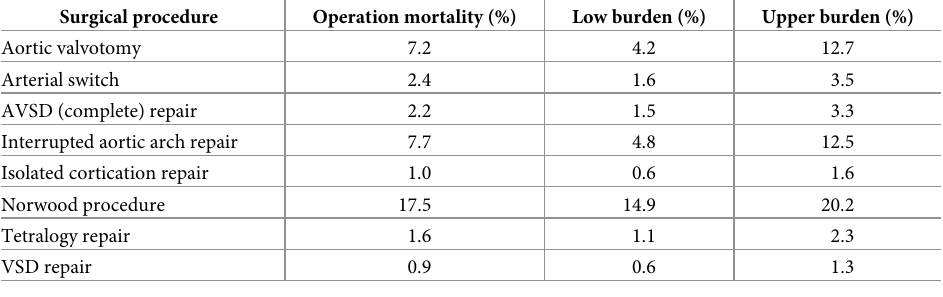
Table 3. Procedure-specific operation mortality (30-day